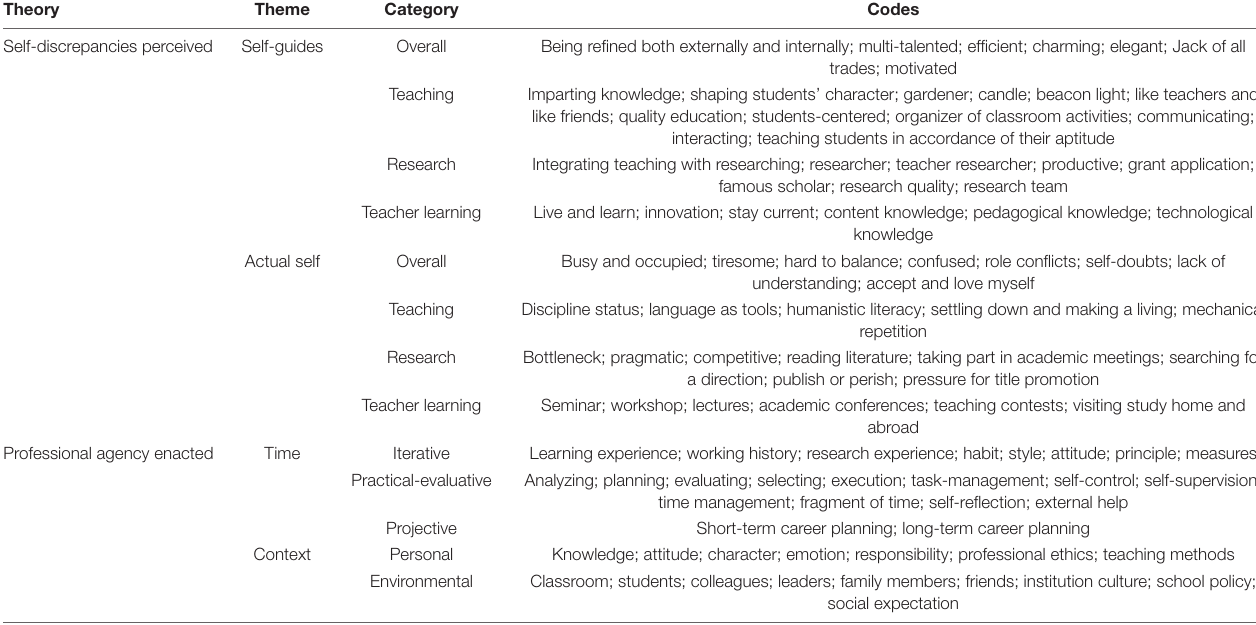
TABLE 3 | Protocol of the coding